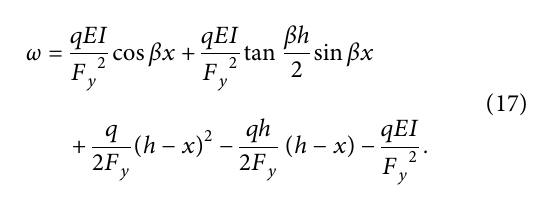
zoneTransition Potential zoneFracture zone spalling development Figure 10: Mechanical model of coal